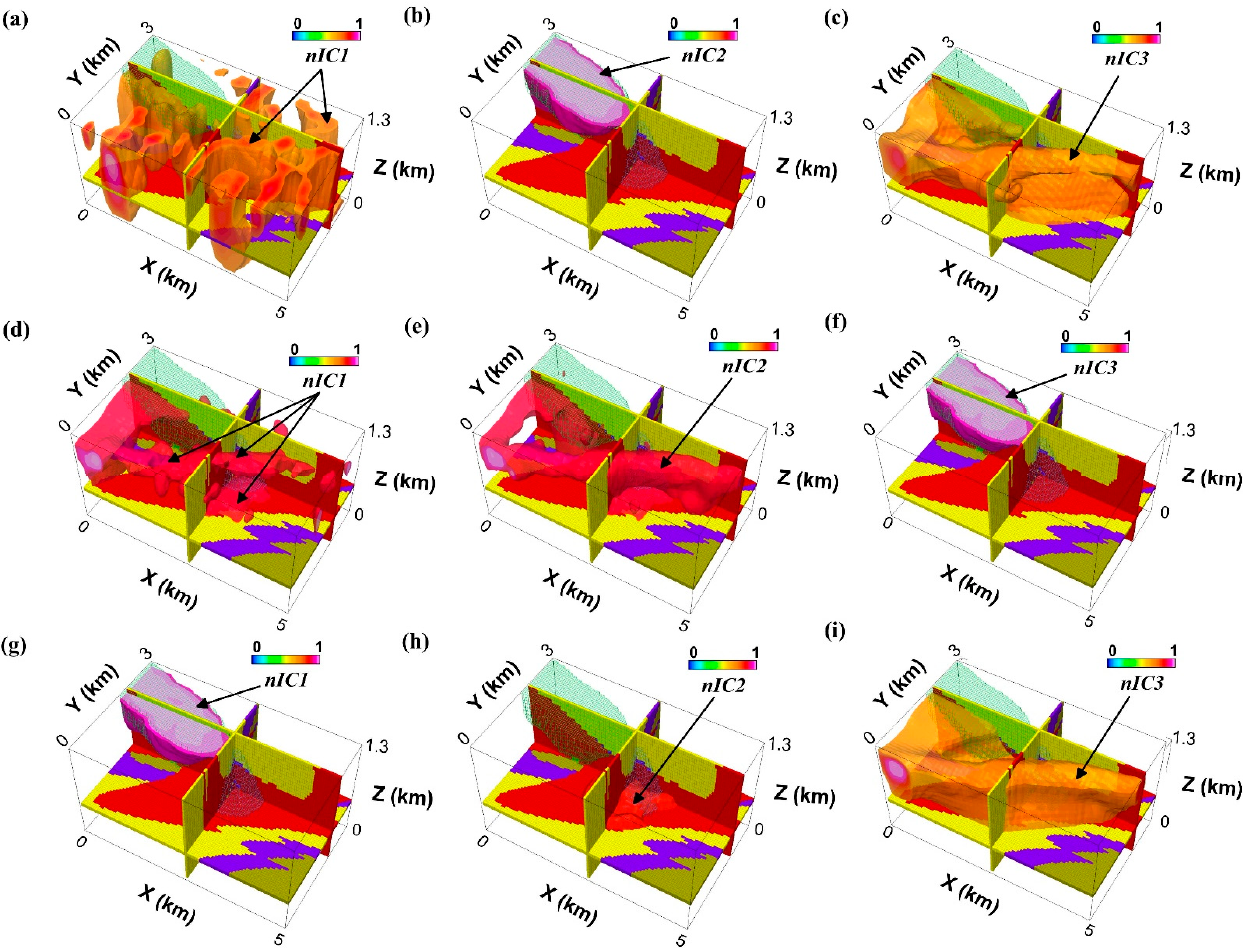
Figure 10. Post-inversion feature extraction through negentropy maximization on different inversion scenarios: ( a – c ) independent components of smoothest physical properties; ( d – f ) independent components of sharper physical properties; ( g – i ) independent components of sharpest physical properties.